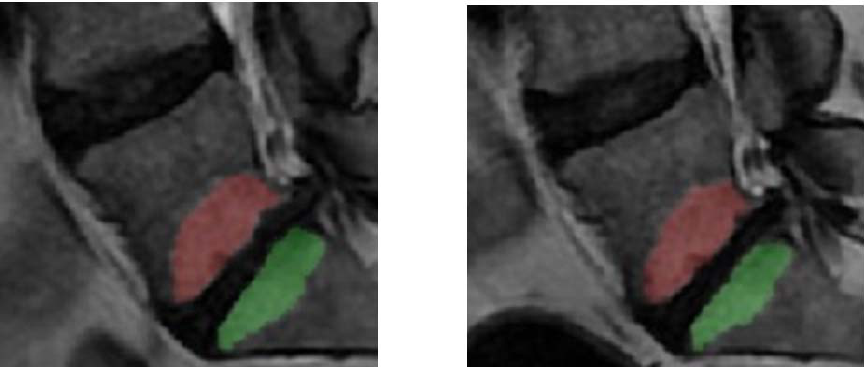
Figure 2. Example of segmented Modic change (MC) in L5 and in S1 at MRI without ( left ) and with ( right ) spinal loading .